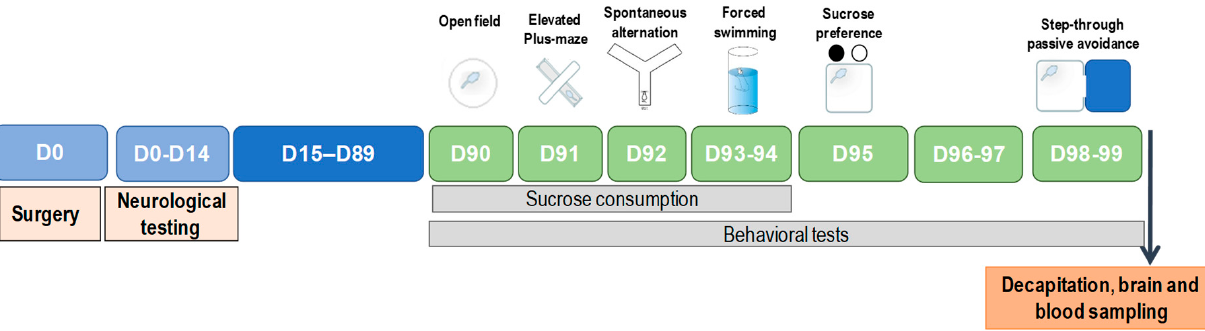
Figure 1. Experimental design.